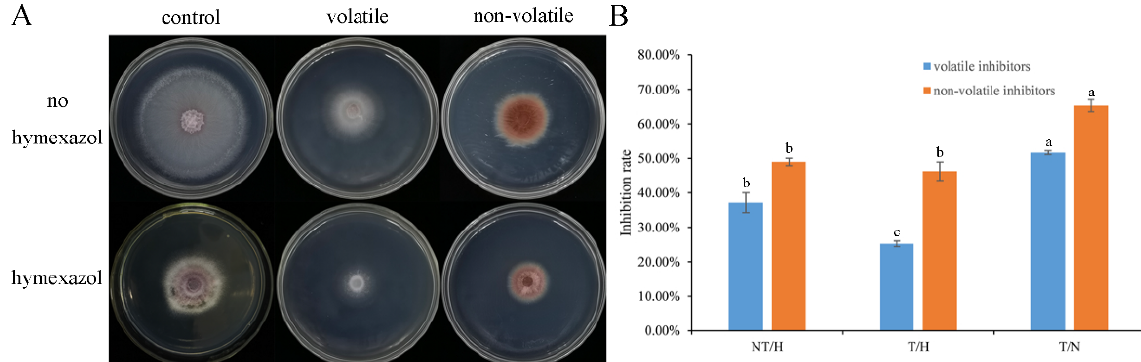
Figure 4. Effect of volatile and non-volatile metabolites produced by T. asperellum SC012 to F. oxysporum FC018 at the presence or absence of 50 µg mL − 1 hymexazol. ( A ) F. oxysporum FC018 grown on PDA medium affected by volatile and non-volatile metabolites; ( B ) the inhibition rates of volatile and non-volatile metabolites to the growth of F. oxysporum FC018. Data presented are the means ± SE. The lowercase letters indicate significant difference ( p < 0.05) among the treatments.